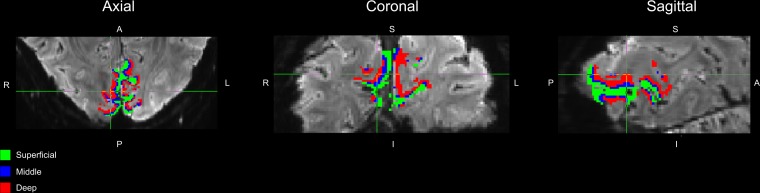
Example cross section of V1 mask.Axial (left), coronal (middle) and sagittal (right) views of a cross section of one example subject’s V1 mask. Superficial, middle and deep voxels are colored in green, blue and red, respectively. Note that in our spatial GLM approach (described in Materials and methods), voxels’ contributions to layer-specific time courses were weighted by their proportion overlap with each layer. For the purposes of visualization in this figure, voxels are labeled according to which layer they maximally overlapped with.